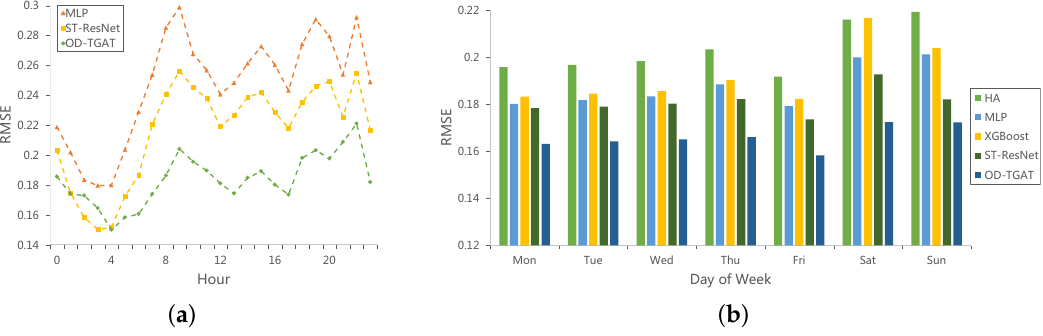
Figure 8. Performance on Different Time Scales. ( a ) Performance on different hours in one day. ( b ) Performance on different days in one week.